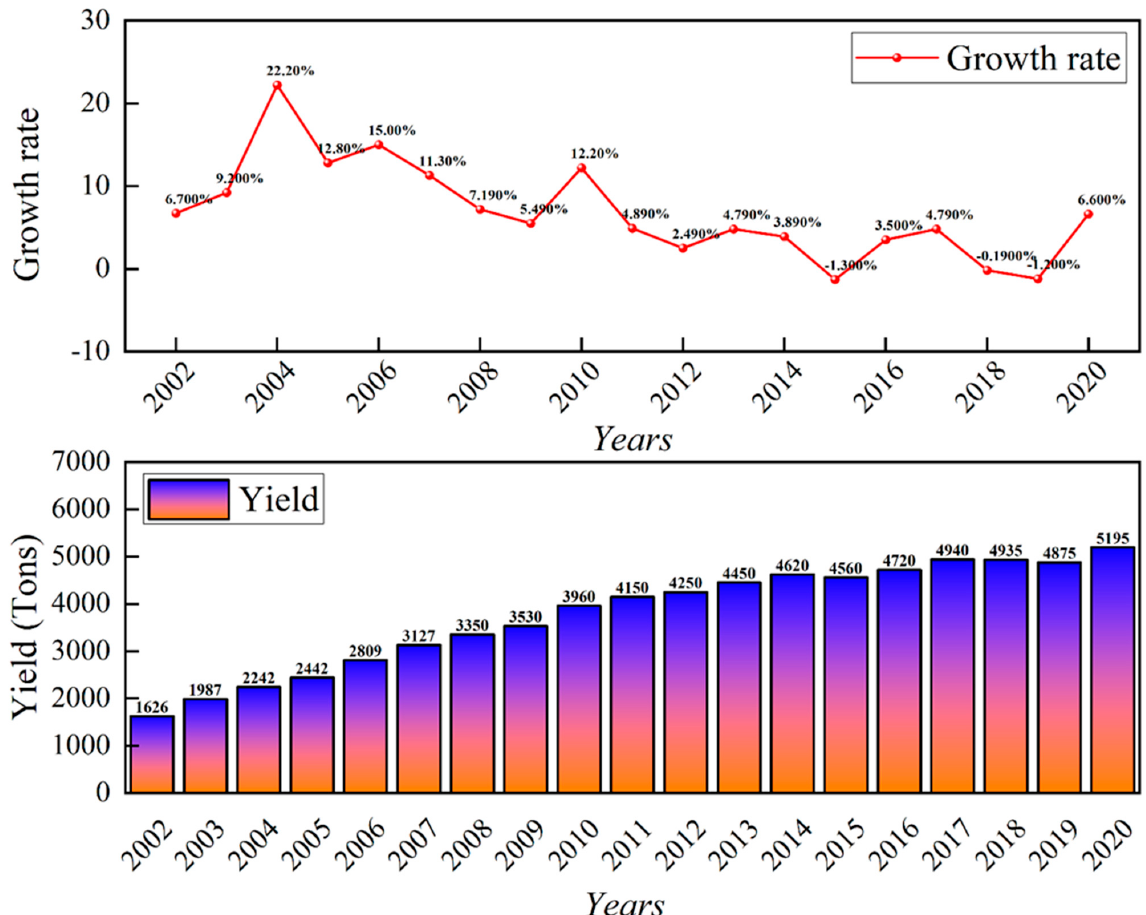
Figure 8. China’s casting production and growth rate in recent years.